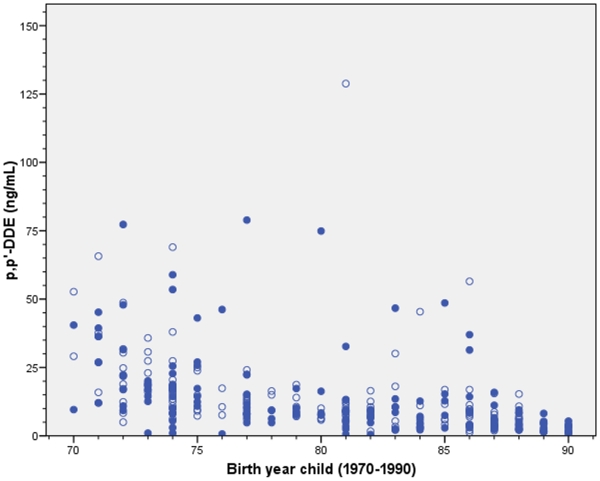
The median maternal serum concentrations of p,p′-DDE from 1970–1990.